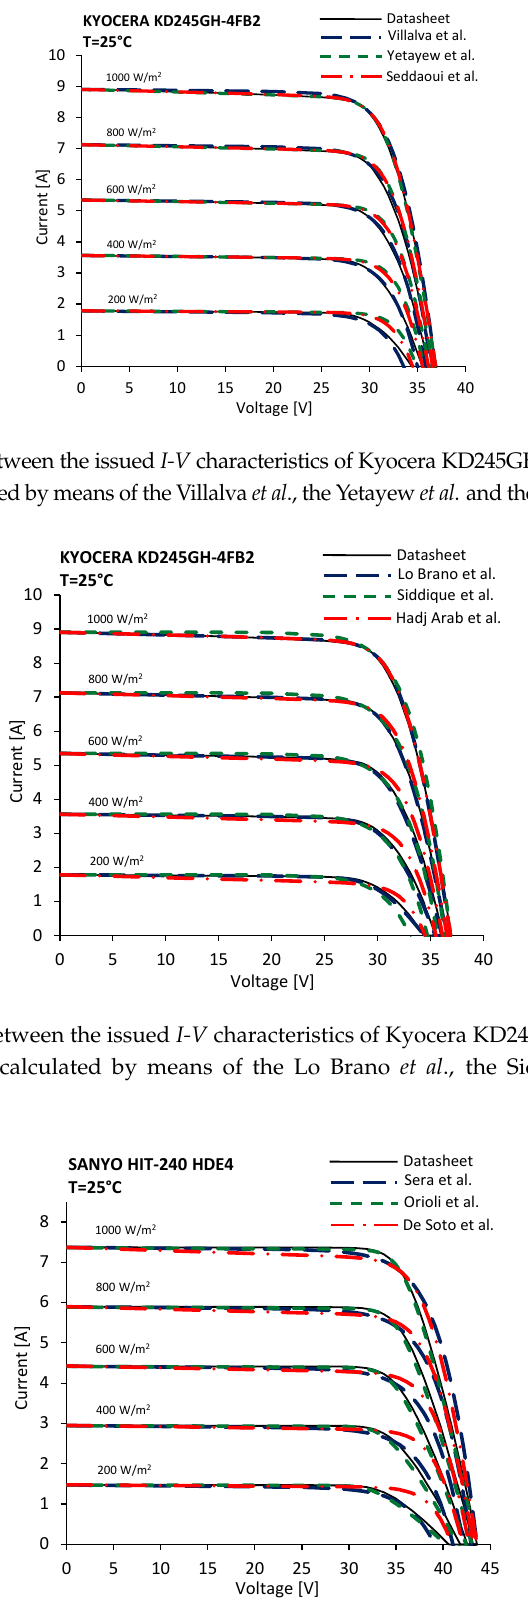
Figure 7. Comparison between the issued I-V characteristics of Sanyo HIT-240 HDE4 at T = 25 °C and